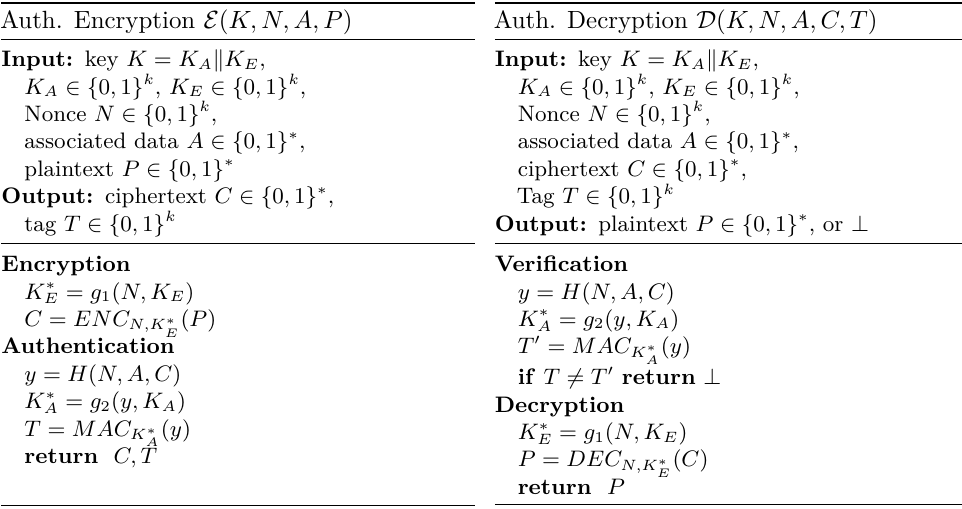
Algorithm 2: Authenticated encryption and decryption